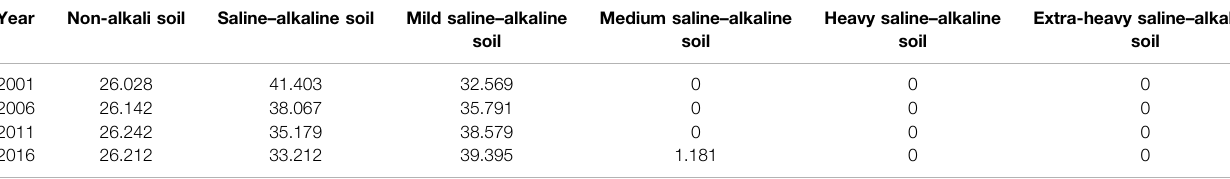
TABLE 4 | Proportion of soil area with different degrees of salinization from 2001 to 2016 (unit: